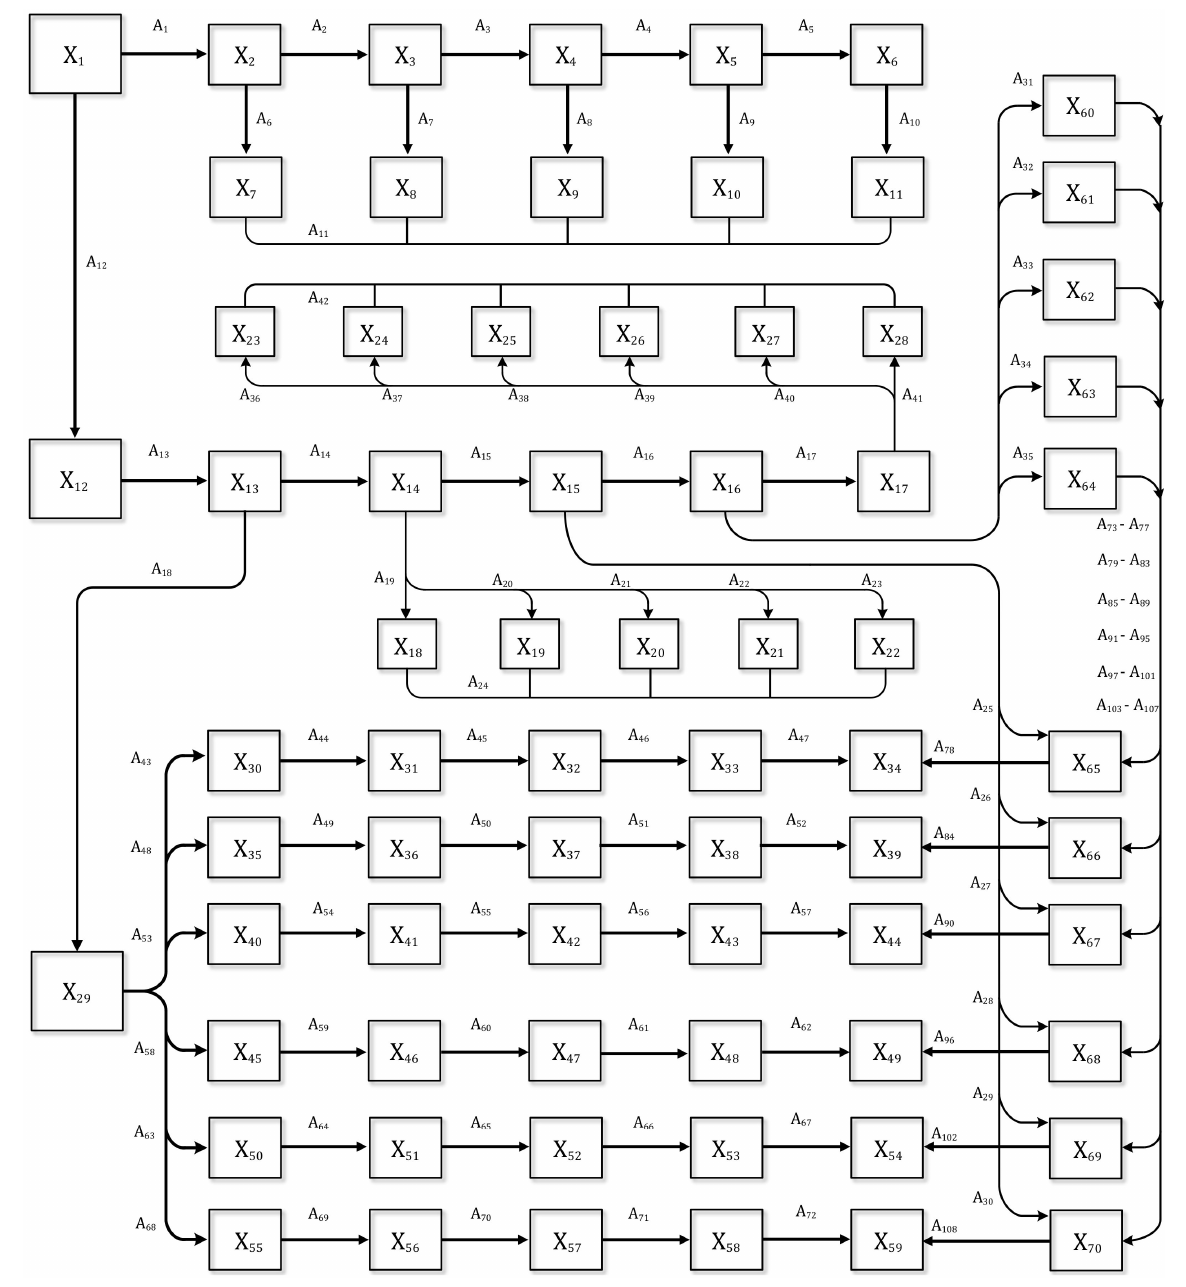
Figure 12. Mixed asymmetric graph G = ( X , A )